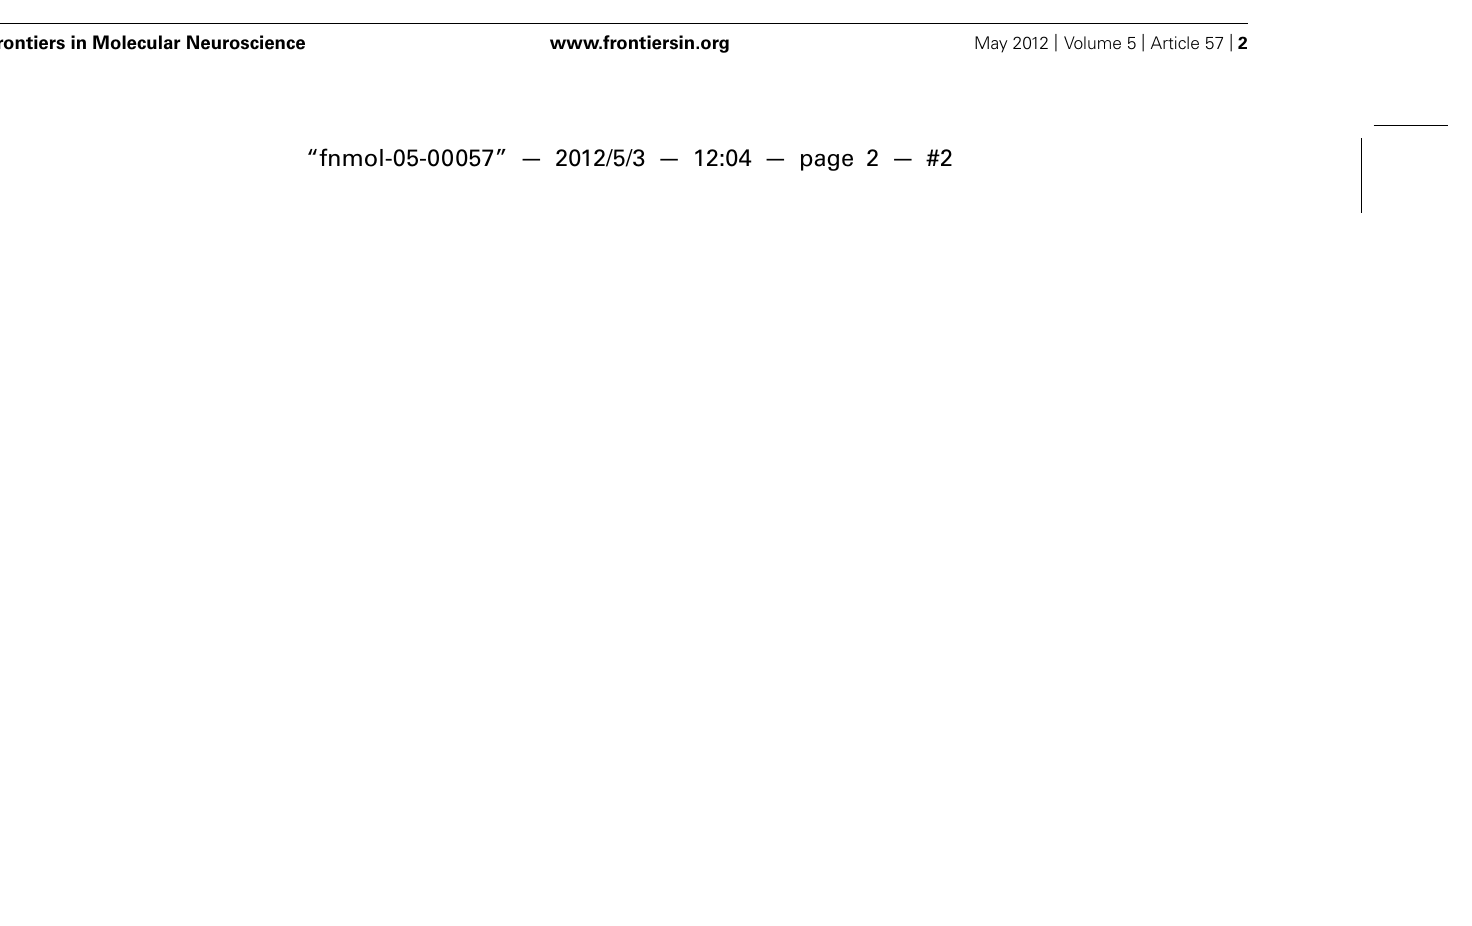
required for dynamin and clathrin-dependent endocytosis. Activation of the G-protein coupled mAChR induces the release of Ca 2 + from intracellular stores. Increased levels of Ca 2 + are sensed by hippocalcin. As a consequence of this, PSD-95 disassociates from NMDARs. AP2 is now free to bind with NMDARs and initiate their endocytosis. (D) The hypothetical model of Ca 2 + -mediated A β toxicity.The aberrant activation of synaptic receptors leads to enhanced Ca 2 + influx from both extracellular sites and intracellular Ca 2 + stores. Ca 2 + entry via NMDARs can impair mitochondrial function, leading to the release of cytochrome c and the formation of the apoptosome. This activates caspase-3, which cleaves and inhibits Akt-1. Given that Akt-1 ordinarily functions to phosphorylate GSK-3 β and thereby downregulate the activity of GSK-3 β , without this constitutive inhibition GSK-3 β is now able to induce AMPAR endocytosis (Lopez etal., 2008; Li etal., 2009; Jo etal., 2011). Similarly, sustained release of Ca 2 + from intracellular stores is likely to be sensed by, for example, PICK1. One likely consequence of this is the induction of LTD-signaling mechanisms and the endocytosis of